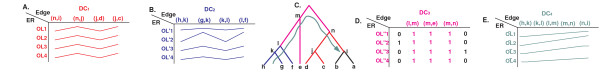
Illustration of the four measures of local co-evolution (A. Dc1, B. Dc2, D. Dc3 and E. Dc4) along a hypothetical evolutionary tree (C.). A. In the case of Dc1, the co-evolution score is high when values of all the OLs along a sub-tree are similar. B. In the case of Dc2, the co-evolution score is high when values of all the OLs along a sub-tree are correlative (i.e. the OLs tend increase/decrease on the same branches). D. Dc3 is used for finding a large subtree and a set of orthologs with identical labeling along most of a subtree. E. Dc4 is used for finding sets of orthologs that have similar monotonic/non-monotonic decreasing/increasing evolutionary pattern along a path.